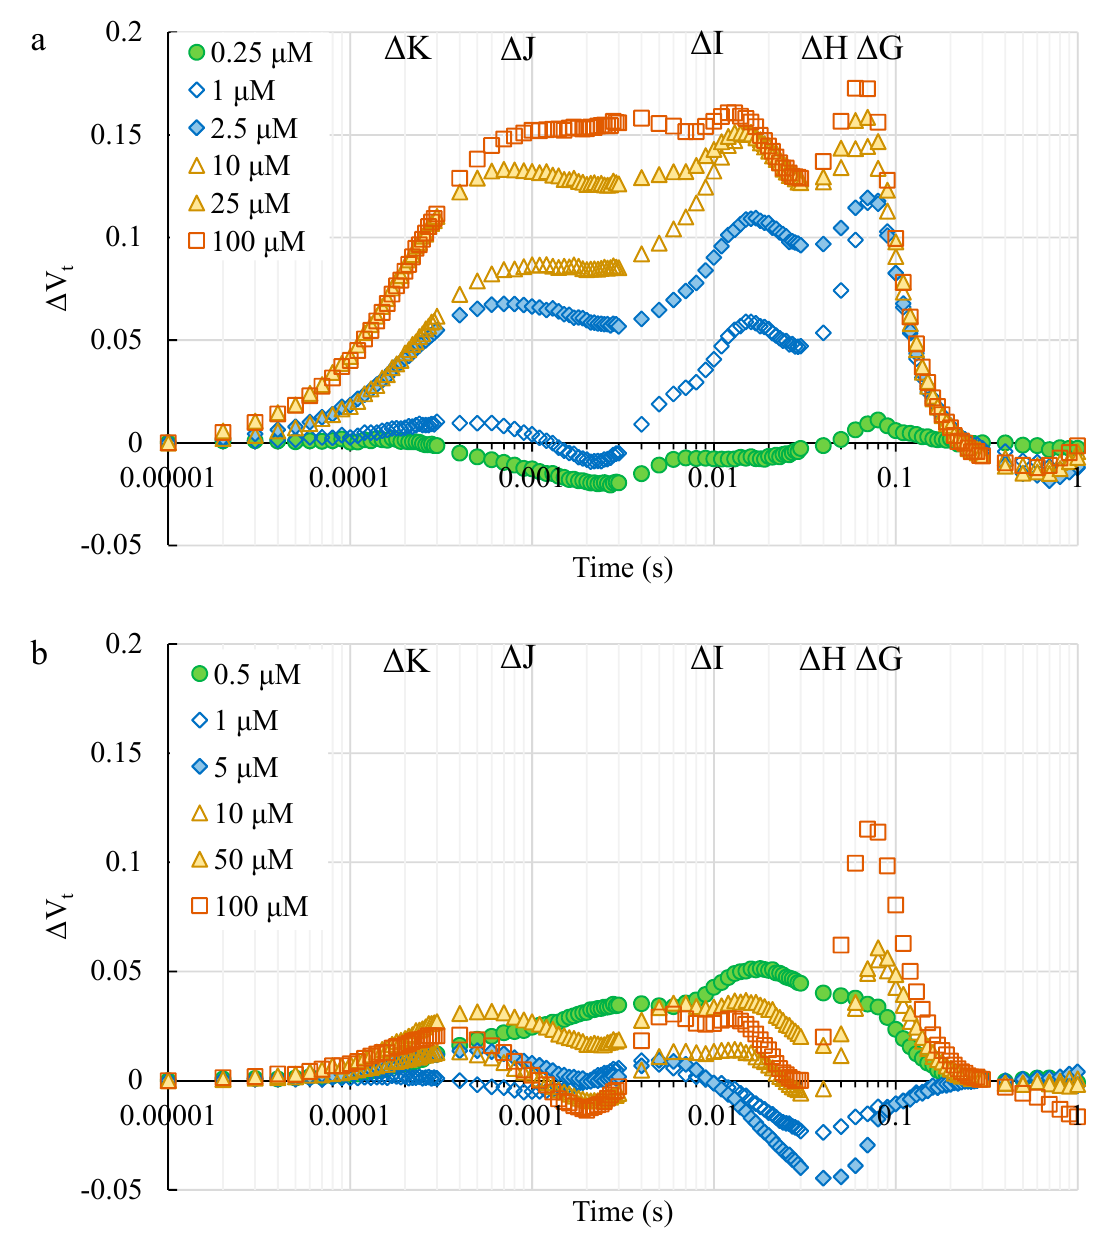
Figure 3. The effect of Cd ( a ) and Pb ( b ) on the relative variable fluorescence of the chlorophyll a ( Δ V t = ((F t – F 0 )/F v ) – V control ) of the studied corn leaves. For the Δ V t analysis, the fluorescence of the leaves of the control plant was the reference and equaled 0. The values are the means ( n = 15).